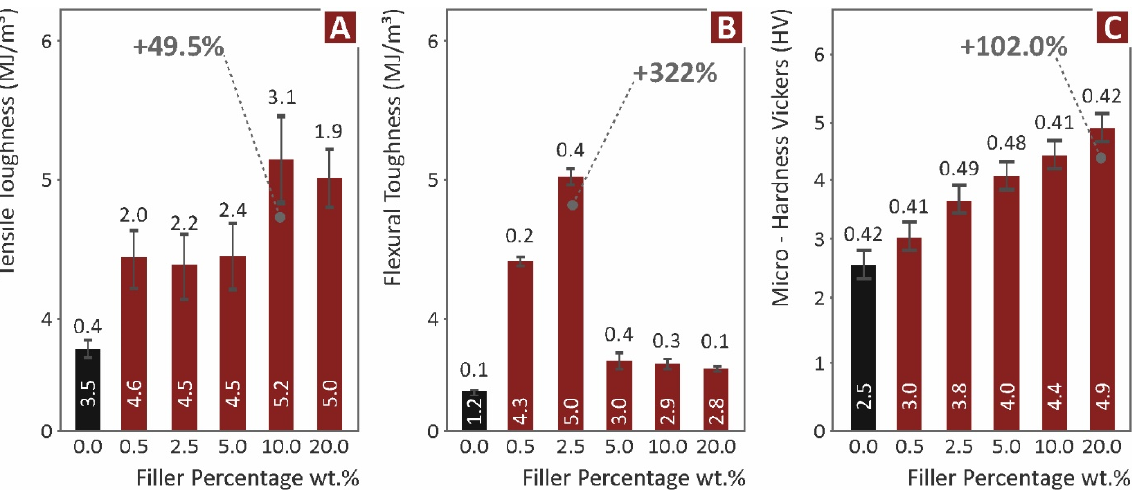
Figure 4. ( A ) Average calculated tensile toughness and deviation of unfilled HDPE thermoplastic and HDPE with ZnO composites, ( B ) Average calculated flexural toughness and deviation of unfilled HDPE thermoplastic and HDPE with ZnO composites and ( C ) average Vickers micro-hardness including st. dev. results for unfilled HDPE thermoplastic and HDPE with ZnO